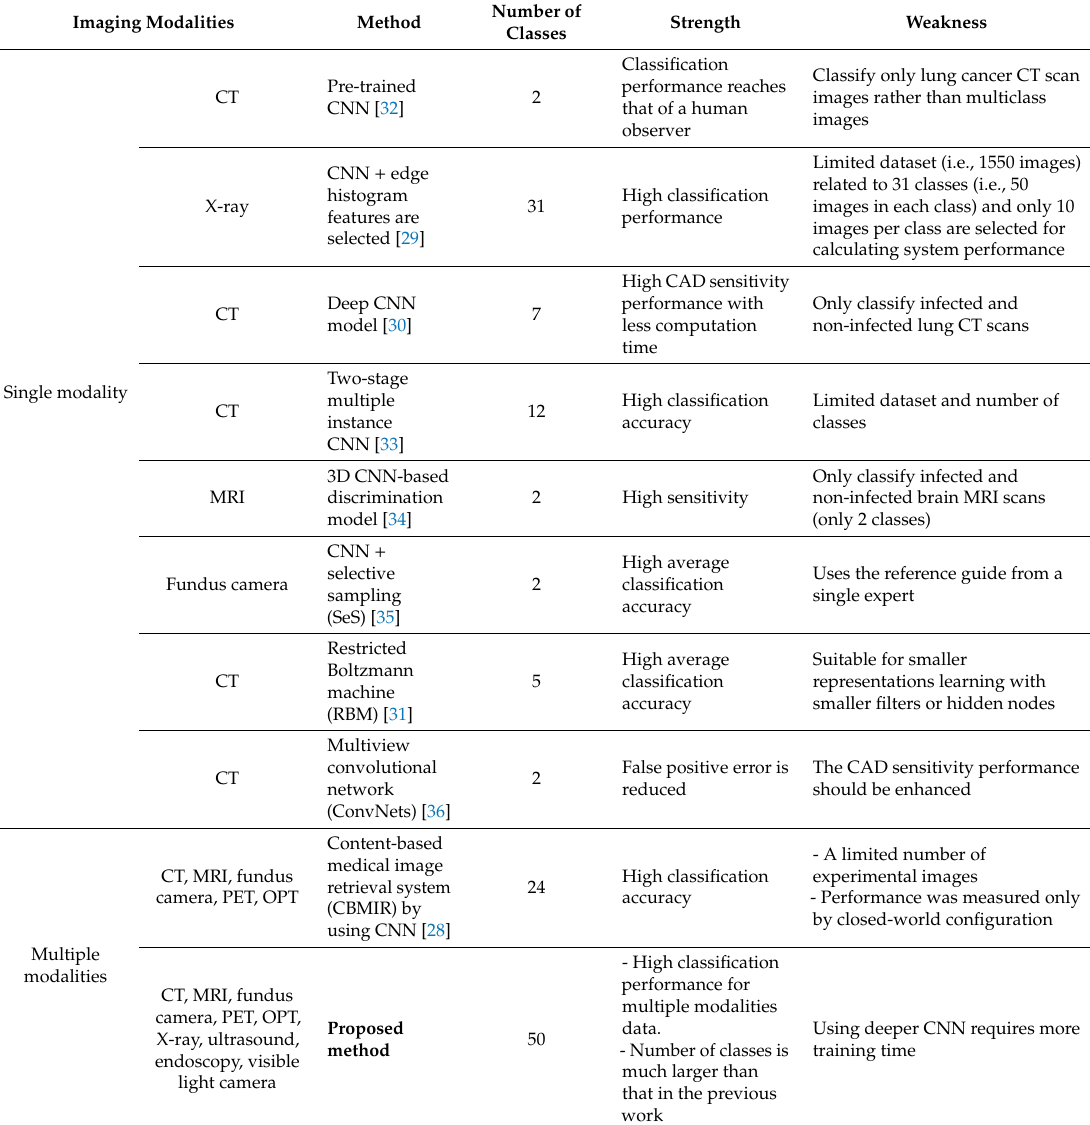
Table1. Comparisonofourproposedandexistingmethodsformedicalimageclassificationandretrieval. Imaging